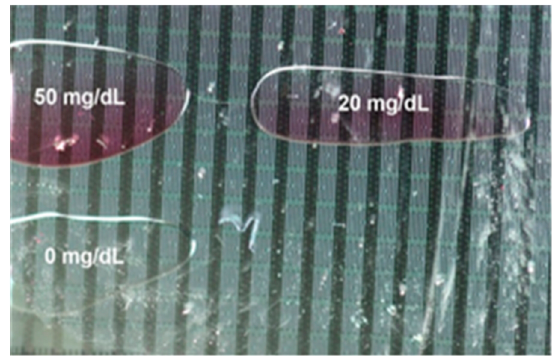
Figure 7. Colorimetric glucose assay demonstration on-chip showing three different glucose